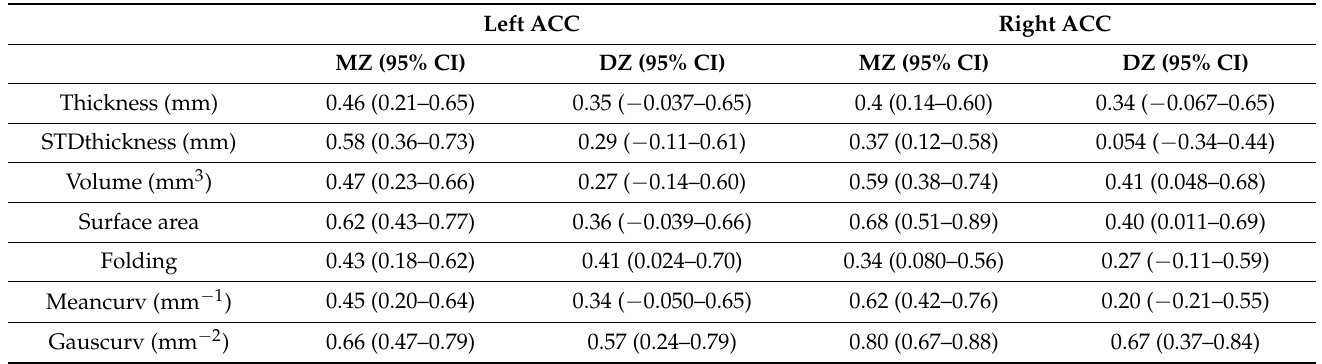
Table 5. Intraclass correlation coefficients of surface morphological parameters.